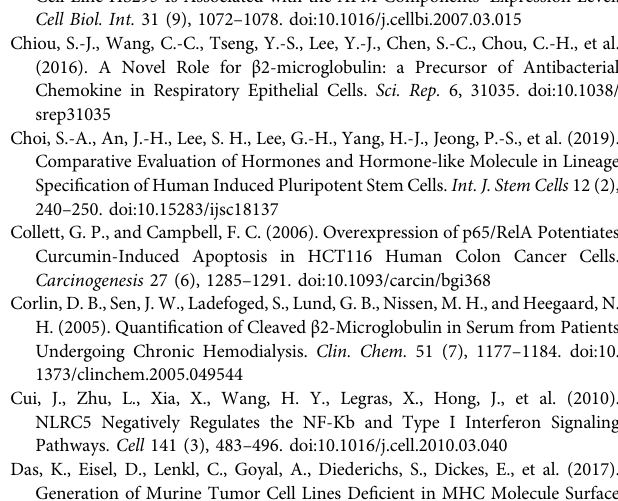
Supplementary Figure S2 | In vivo teratoma formation assay of the iPSC line. Characterization of the differentiation potential of the iPSC line used to generate gene-edited hypoimmunogenic cell lines. Their differentiation capacity was examined by in vivo teratoma formation assay. H&E images, from left, ectoderm- derived pigmented cells, mesoderm-derived cartilage, and glands from endoderm lineage cells. White arrowheads depict differentiated cell types in teratoma. Magni fi cation × 40. Scale bar, 200 μ m. Supplementary Figure S3 | Characterization of β 2m KO cell lines using western blot and immunocytochemistry. (A) Lane1: lysate of control iPSC (CTRL iPSC), Lane2-5: lysate of b2m KO cell lines (the number of cell lines is indicated at each lane), GAPDH as housekeeping gene. (B) Immuno fl uorescence micrographs against b2m (red) and nucleus (Hoechst 33342, blue). The representative images were taken in control iPSC colony (Ctrl iPSC) and the b2m KO cell line (b2m KO #A16). Scale bar, 250 μ m. Supplementary Figure S4 | Off-target analysis. (A) gRNA sequence used for cell line construction and the protospacer adjacent motif (PAM) sequence (red). Predicted all-exonic off-target sites; mismatched sequences are in small red letters. (B) Reference sequences of 10 exonic off-target sites from NCBI (reference seq, GRCh38.p13) and sequences of wild-type (Ctrl iPSC) and hypoimmunogenic (A5 and A9) cell lines. Supplementary Figure S5 | Differentiation of iPSCs into hematopoietic and neural lineages. (A) Schematic of hematopoietic and neural differentiation, with representative light micrographs. (B,C) Immuno fl uorescence micrographs of neural stem cell markers (B) and a neuronal marker (C) . Nestin (green), Sox (red), Tuj1 (green), and nucleus (Hoechst 33342, blue) were stained. (D) Flow cytometry data for hematopoietic stem cell markers in cells differentiated from WT (control), β 2m knock-out ( β 2m KO), and hypoimmunogenic (A5 and A9) iPSCs. Scale bar, 250 μ m. Supplementary Figure S6 | Flow cytometry analysis of HLA-I expression in response to IFN- γ treatment and withdrawal. (A) HLA-BC and HLA-G expression patterns in wild-type (Ctrl NSC) and gene-edited (A9 NSC) NSCs under normal conditions (non-treated), after IFN- γ treatment (48 h IFN- γ ), and 3, 9,and13 daysafterIFN- γ withdrawal(w/oIFN- γ D+3,+9,and+13). (B) RelativeMFI values at the indicated timepoints ( n = 3). Supplementary Figure S7 | EGFP cell line generation and characterization before and after differentiation. (A) Schematic of the HR donor template plasmid for EGFP cell line generation. (B) EGFP expression in pluripotent cells (iPSC) and neural cells (NSC) differentiated from the wild type (Ctrl) and (EGFP) EGFP cell lines. Supplementary Figure S8 | HLA-G expression patterns in response to lysosomal inhibitors. (A) HLA-G expression in the non-treated control (NTC) and after 48 h of 25 ng/ml IFN- γ (IFN- γ ) and 50 μ M chloroquine (CQ) treatment. (B) Representative confocal micrographs of NSCs. Nuclei were stained with Hoechst 33342 (blue). HLA-G was stained with β 2m and a secondary antibody (red), and lysosomes were stained using an APC-conjugated LAMP-1 antibody (cyan). Scale bar, 50 μ